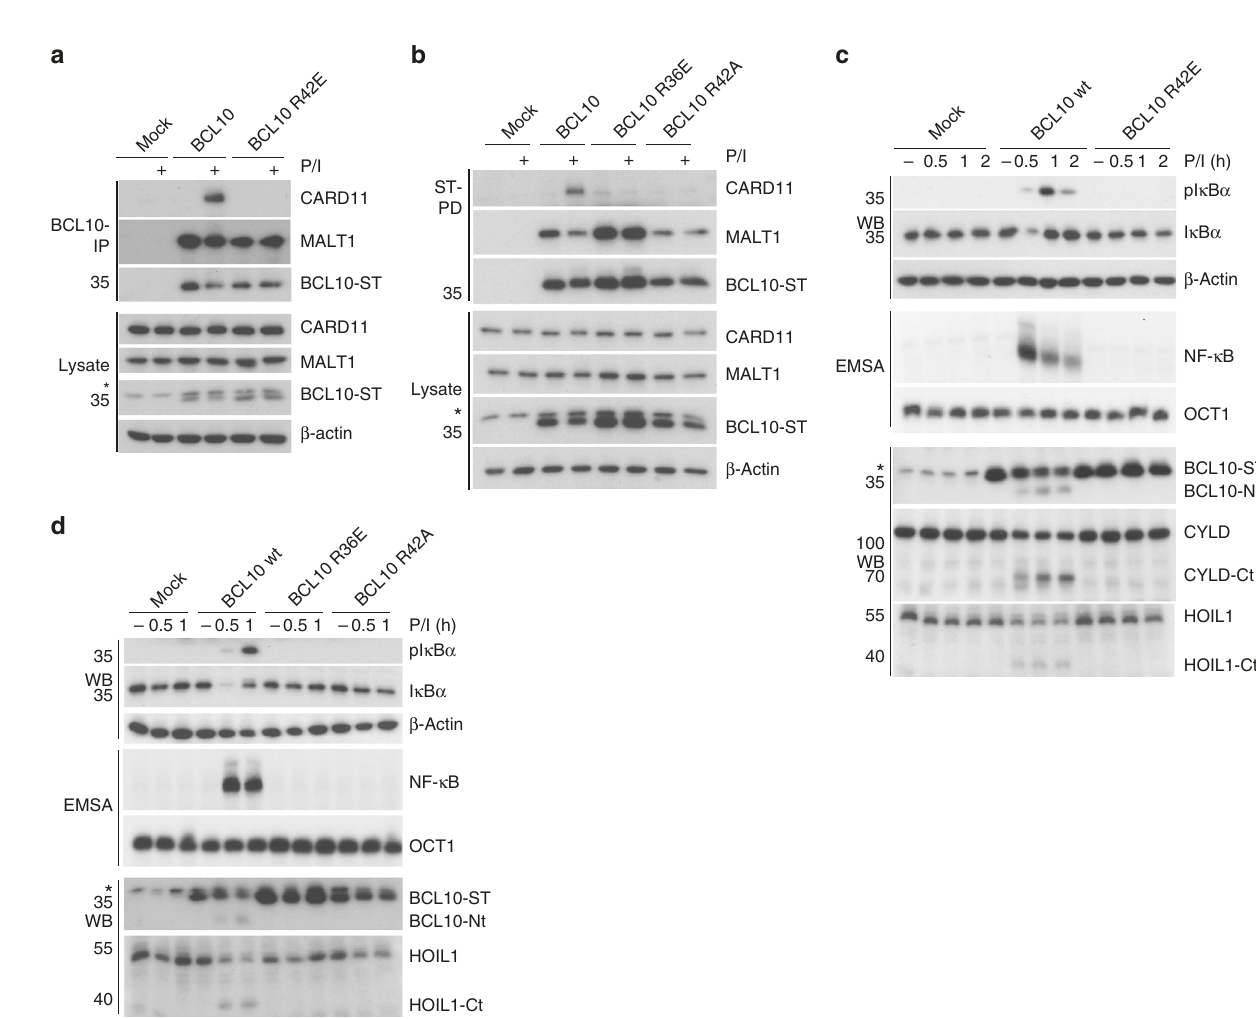
Fig. 3 Functional analyses of BCL10-BCL10 interfaces in Jurkat T-cells. a , b BCL10 KO Jurkat T-cells lentivirally reconstituted with BCL10 wt, R42E, R36E or R42A constructs were stimulated P/I for 20 min and CBM complex formation was monitored by BCL10-IP ( a ) and Strep-tag II (ST) pull down (PD) ( b ). c , d BCL10 KO Jurkat T-cells reconstituted with BCL10 wt or BCL10-BCL10 interface mutants were stimulated with P/I for the times indicated. NF- κ B activation was determined by I κ B α WB and EMSA. Activation of the MALT1 protease was monitored by WB analyses of the substrate cleavage. Asterisks